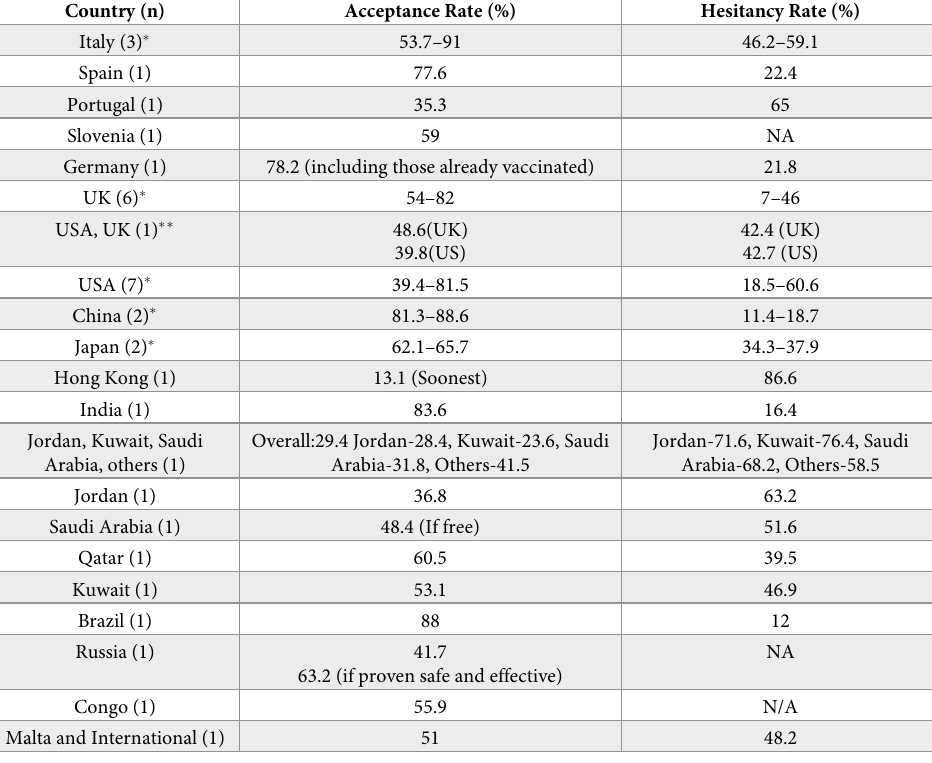
Table 3. COVID-19 vaccine acceptance and hesitancy rates by